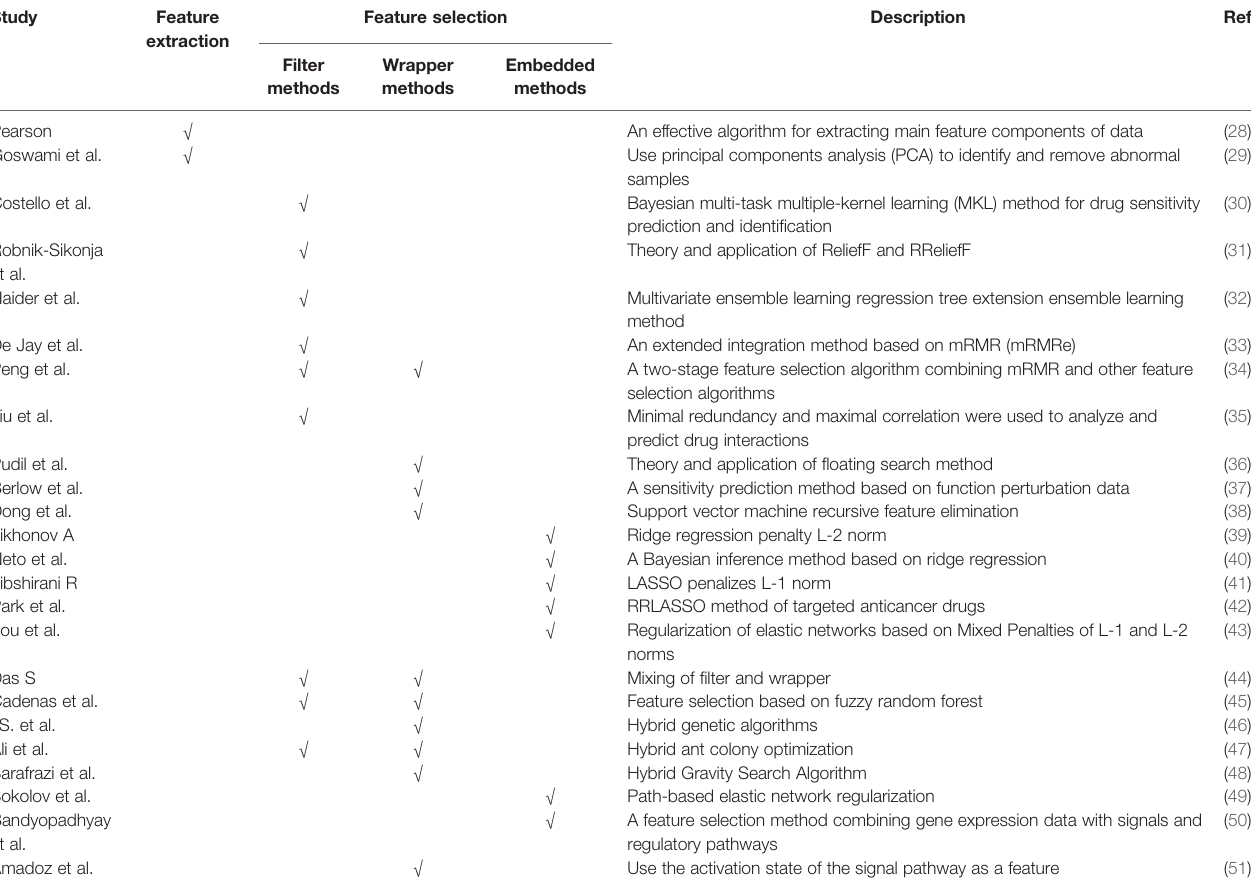
TABLE 1 | Feature-based